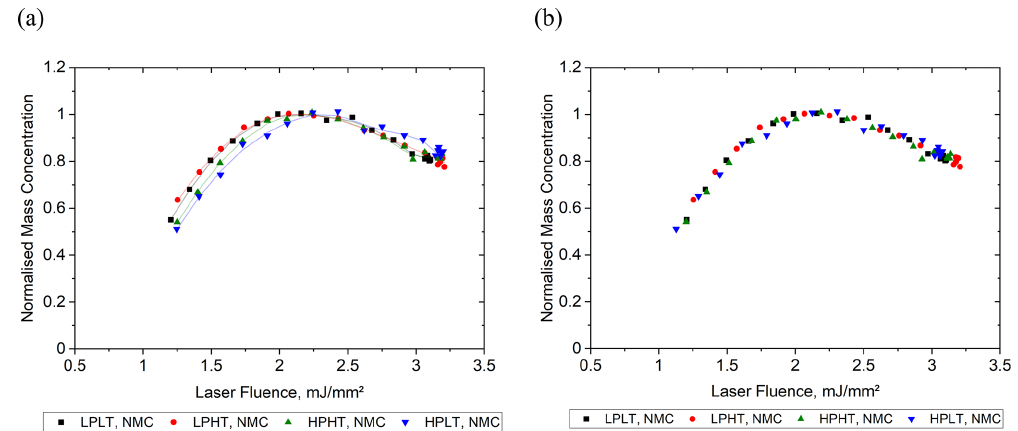
Figure 9. Laser fluence sweep performance using Rig B as the nvPM source, with four operating conditions. NMC – normalised mass concentration. Superimposed are the best-fit curves from the Loess method. (a) Original output from the LII instrument and (b) the laser fluence axis of HPHT and HPLT was shifted (left shift of 0.05 and 0.12, respectively) to fit the LP curves.